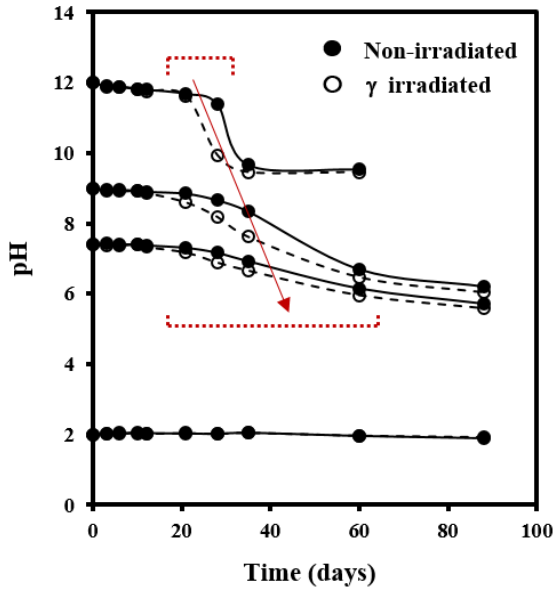
Figure 4. pH evolution of representative degradation media during exposure of non-irradiated (solid lines) and γ irradiated (dashed lines) GL- b -[GL- co -TMC- co -CL]- b -GL samples.